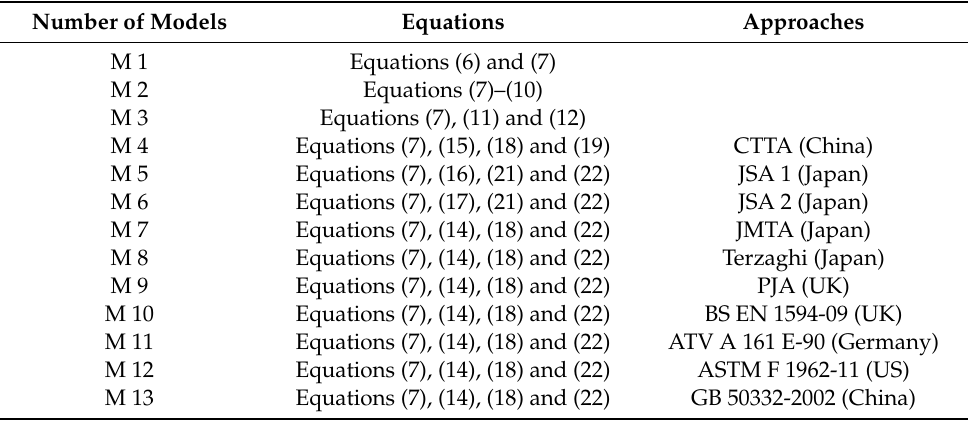
Table 2. The numbering of the existing friction resistance prediction equations.